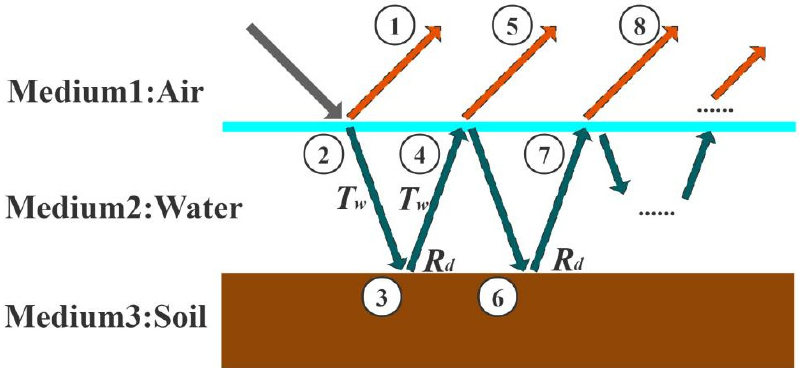
Figure 2. The transmission of light in the simplified soil model.